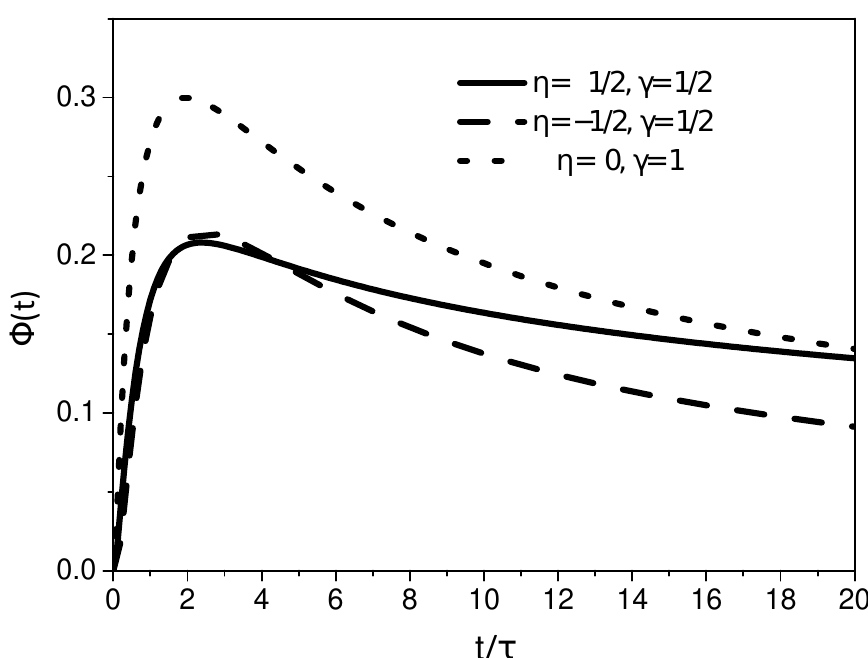
Figure 5. This figure shows the behavior of the distribution for different values of η and γ , with κ ( t ) = ( κ / τ (cid:48) ) e − t / τ (cid:48) . We consider, for simplicity, ¯ κ = 1, τ (cid:48) = τ , x (cid:48) = 1/2, and D τ = 1.